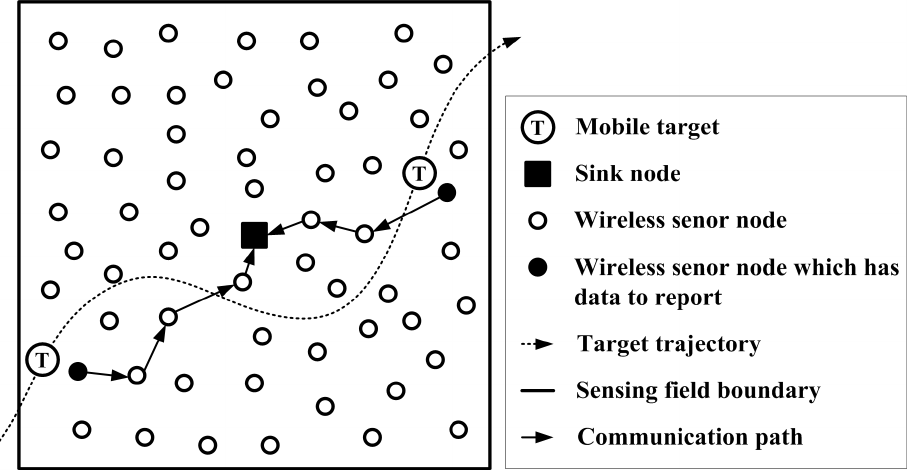
Figure 1. In the target tracking application of WSNs, the mobile target moves through the sensing field and wireless sensor nodes around it will report their data to the sink node in a multi-hop